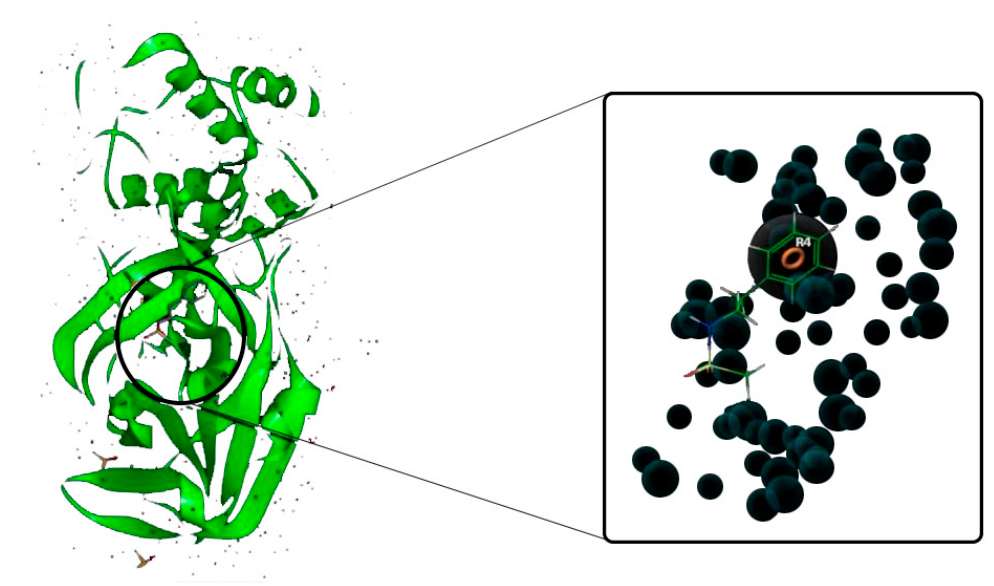
Figure 2. The E-pharmacophore feature (R4) of SARS-CoV-2 (PDB ID: 5R7Y) M pro complex with Z45617795.